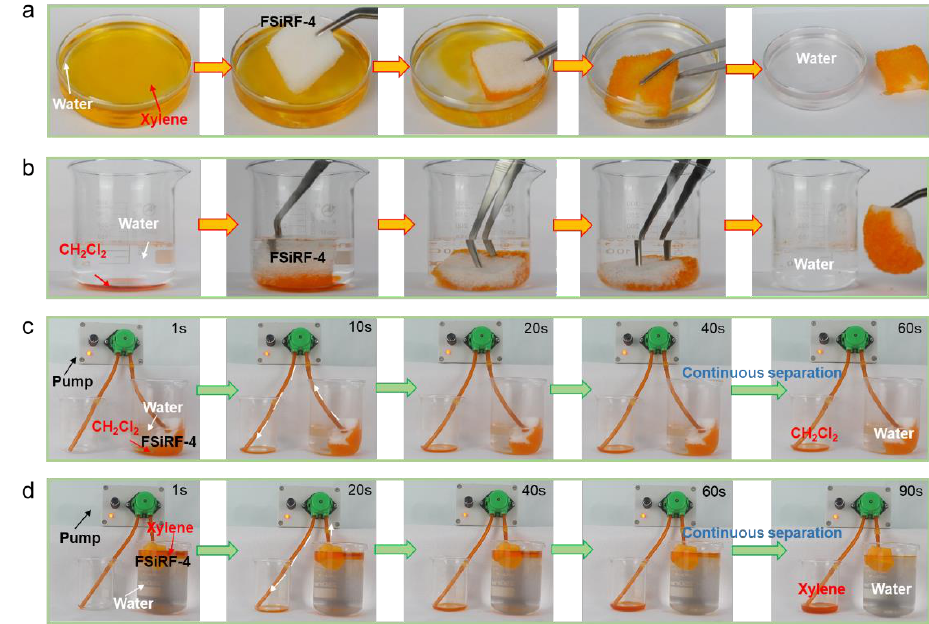
Figure 6. The performance of FSiRF-4 samples in the oil – water separation process. Removal of ( a ) light organic solvent (xylene dyed by orange) on water surface and ( b ) heavy organic solvent (dichloromethane dyed by orange) underwater via FSiRF-4 material, demonstrating good absorption capacity. The illustration of continuous oil–water separation performances of FSiRF-4 by plugging it with a pump, pumping ( c ) light xylene and ( d ) heavy CH 2 Cl 2 from the oil–water mixture via FSiRF-4 samples. They passed through FSiRF-4 porous samples effectively and quickly, and no water went through the sample owing to the excellent surface hydrophobicity and oleophilicity of the